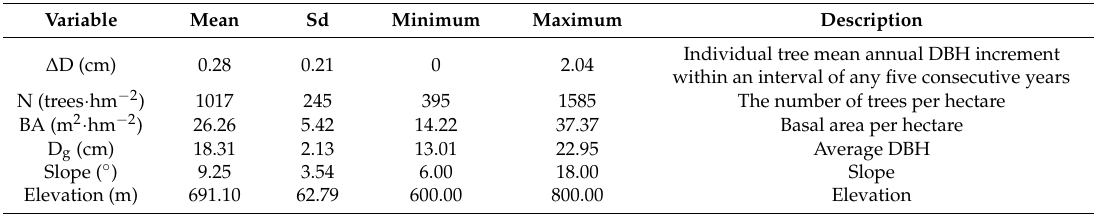
Table 1. Summary statistics of permanent plot data within an interval of any five consecutive years ( n =